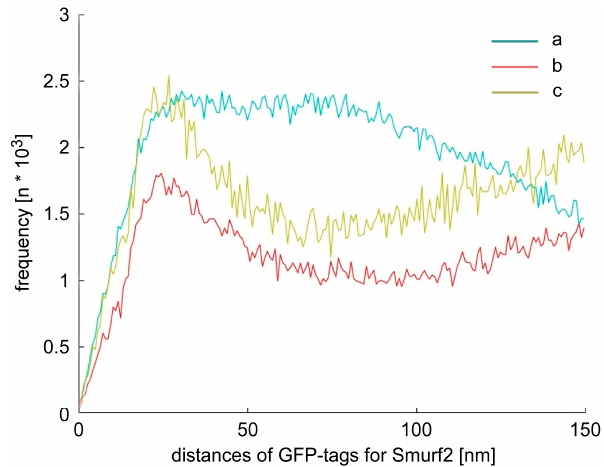
Figure 4. Frequency of pair-wise distances (in nm) of GFP tags for three U2OS cell line modifications: (a) cell line with GFP over-expression; (b) cell line with Smurf2-GFP over-expression; (c) cell line with Smurf2 CG-GFP over-expression. For each curve, 20 cells were measured with 3500 frames per cell. For comparison and interpretation of the curves see Figure 1C.